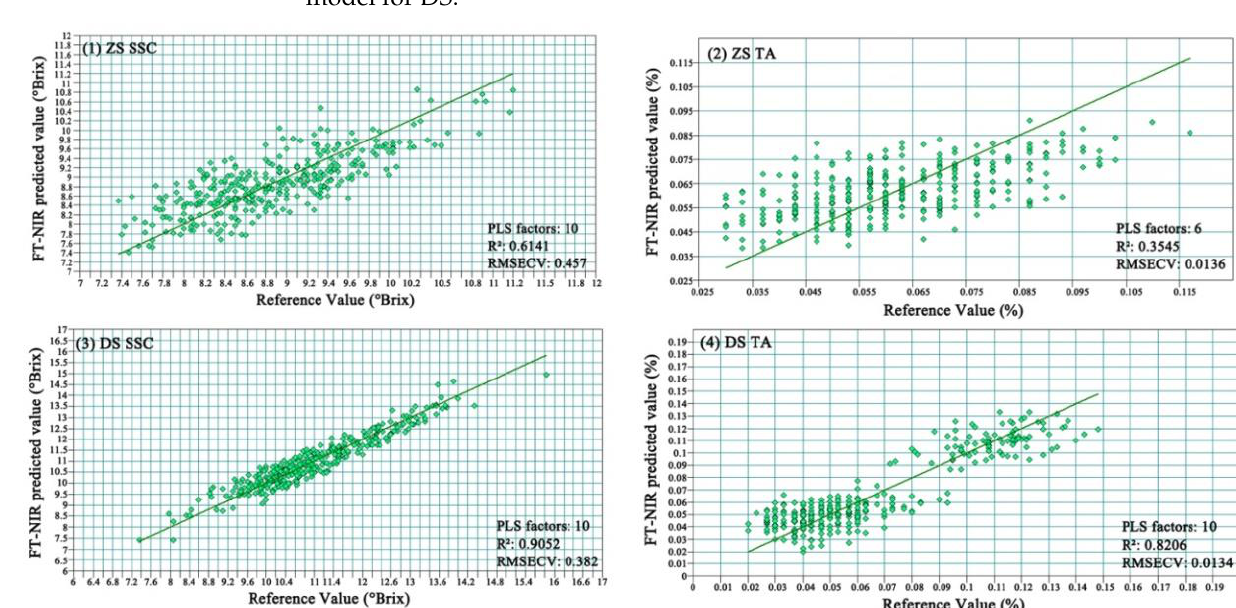
Figure 4. Scatter plot of predicted and measured values of the pear sample prediction model: ( 1 ) SSC model of ZS; ( 2 ) TA model of ZS; ( 3 ) SSC model of DS; ( 4 ) TA model of DS. PLS, partial least squares; R 2 , coefficient of determination; RMSECV, corrected mean squared deviation.